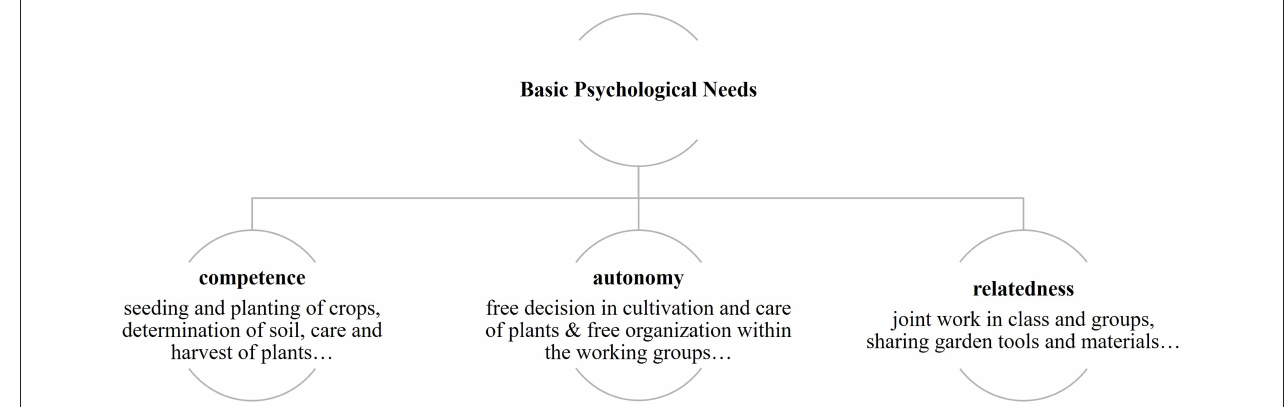
FIGURE 1 | Realization of basic needs—Self Determination Theory